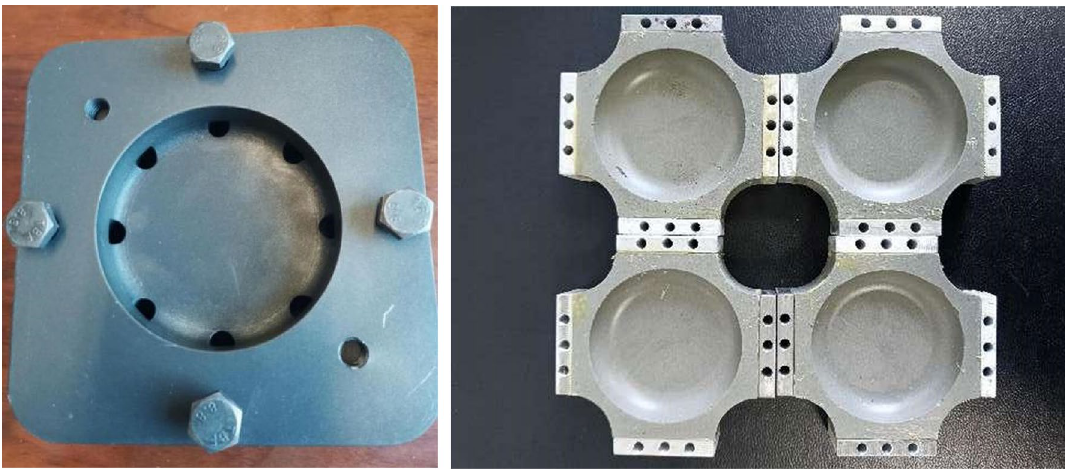
Figure 3. Propellant moulds and test